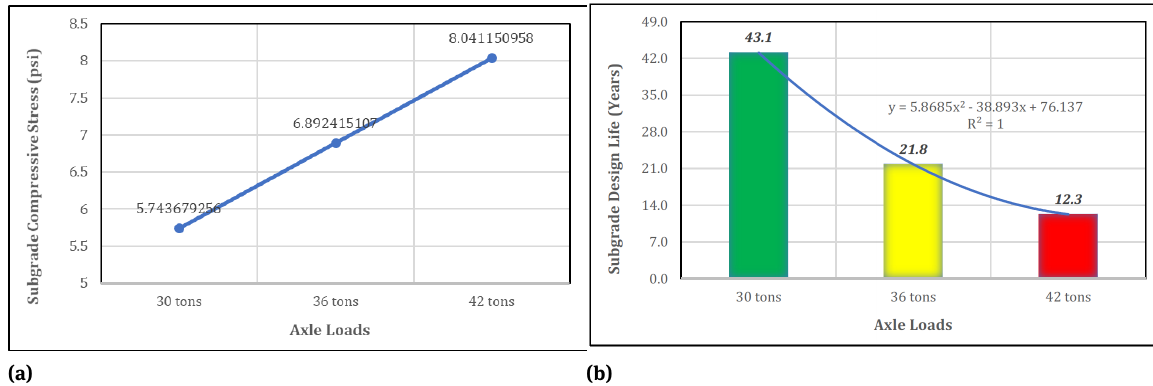
Figure 13: Axle loads effect on subgrade compressive stress (a) and on subgrade service life (b) in asphaltic overlayment track.